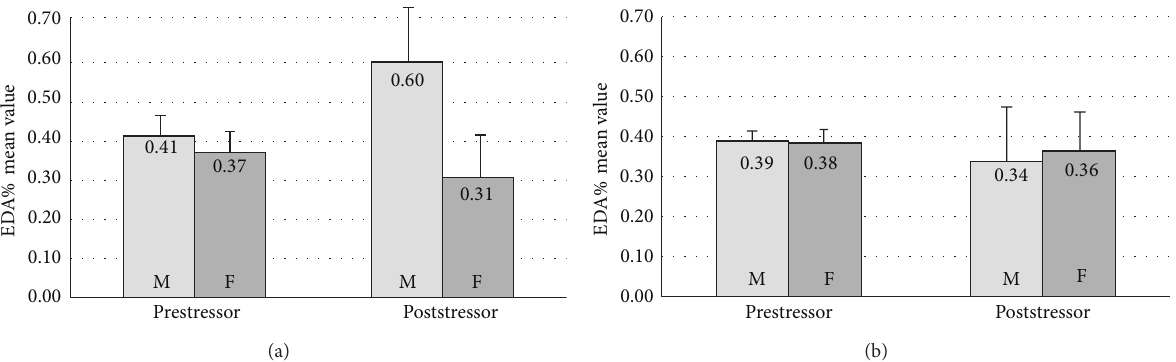
Figure2:Results(treatmentversuscontrolcondition). Notes: F = Female,M = Male.Panel(a)illustratestheresultsofthetreatmentcondition (time-pressured environment), panel (b) illustrates the results of the control condition (no time pressure). Panel (a) The EDA mean values of males are significantly different between the prestressor (0.41) and poststressor (0.60) phases ( 𝑃 = 0.020 ); also, in the poststressor phase the EDA mean values of males (0.60) are significantly different from the EDA mean values of females (0.31) ( 𝑃 = 0.000 ); all other comparisons of EDA mean values do not yield statistically significant differences. Panel (b) There are no statistically significant differences. Error bars show confidence intervals at the